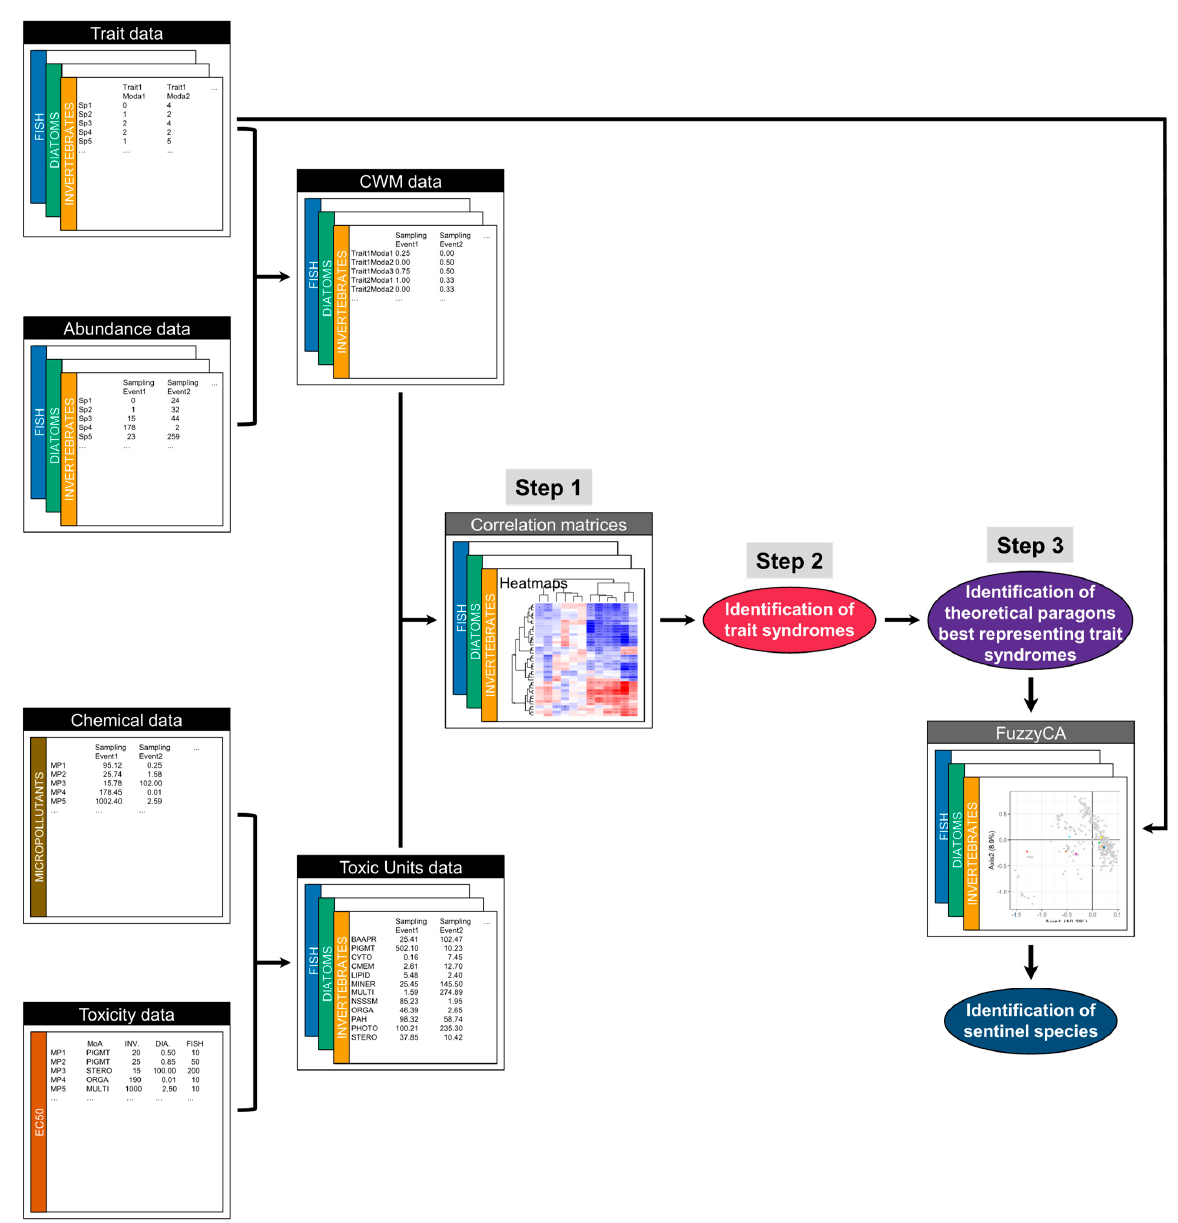
Figure 1. Analytical workflow of the study. CWM = community weighted mean, FuzzyCA = fuzzy correspondence analysis.